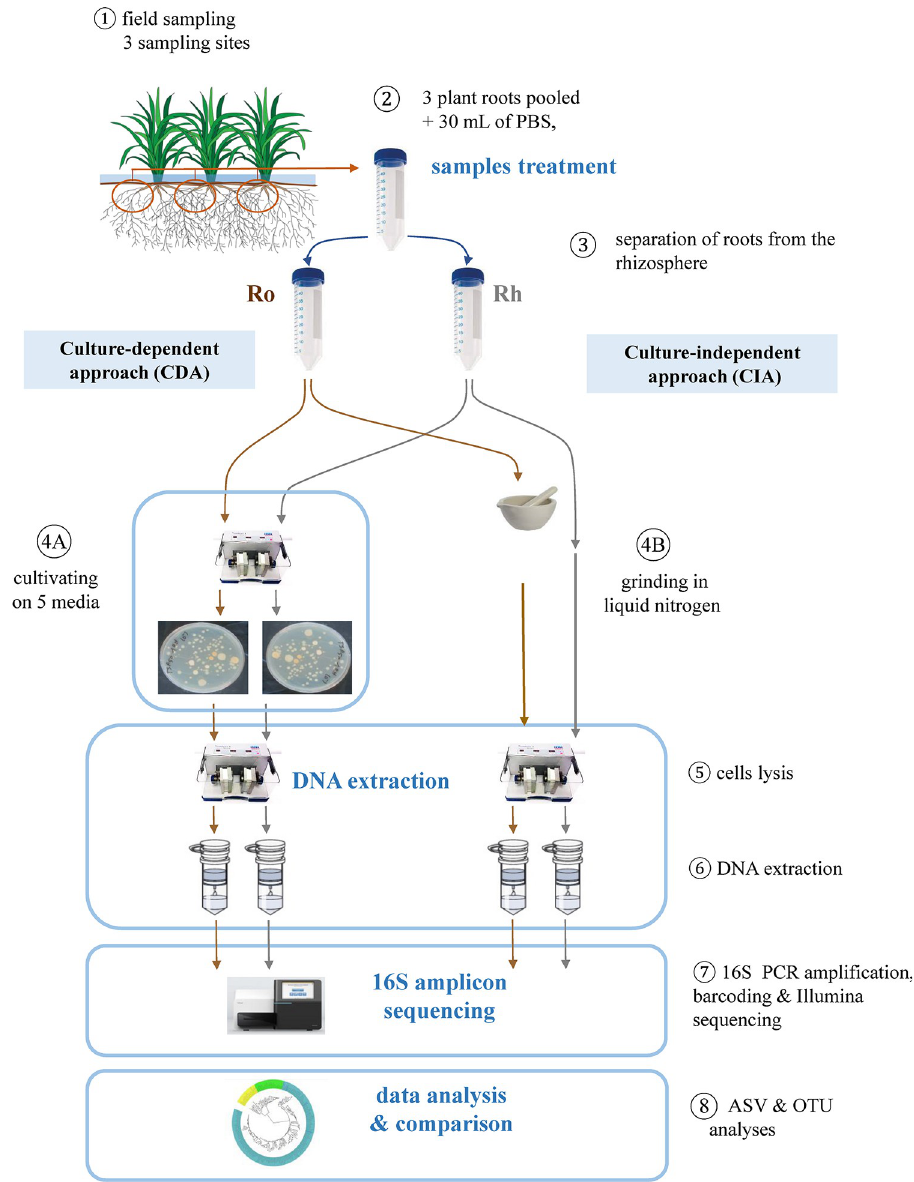
Fig 1. Schematic representation of the sampling and processing protocol for 16S amplicons libraries. Na MoO � 2H2O, with a glucose carbon source (10 g/L) at pH 7; NFb: (g/L), 0.5 K HPO , 0.2 2 4 2 4 MgSO .7H2O, 0.1 NaCl, 0.02 CaCl . 2H2O, 4.5 KOH, 5 malic acid, 2 mL of micronutrient 4 2 solution ((g/L) 0.04 CuSO .5H2O, 0.12 ZnSO .7H2O, 1.40 H BO , 1.0 Na2MoO4.2H2O, 4 4 3 3 1.175 MnSO . H2O), 2 mL of bromothymol blue (5 g/L in 0.2 N KOH), 4 mL of Fe-EDTA 4 (solution 16.4 g/L), 1 mL of vitamin solution ((mg/0.1 L) 10 biotin, 20 pyridoxal-HCl) and pH adjusted to 6.5; RF (g/L): 20 rice flour (prepared from seeds from the FKR64 rice variety), 2.5 yeast extract. Solid and the semi-solid media were obtained by adding 2% and 0.16% g of agar, respectively.